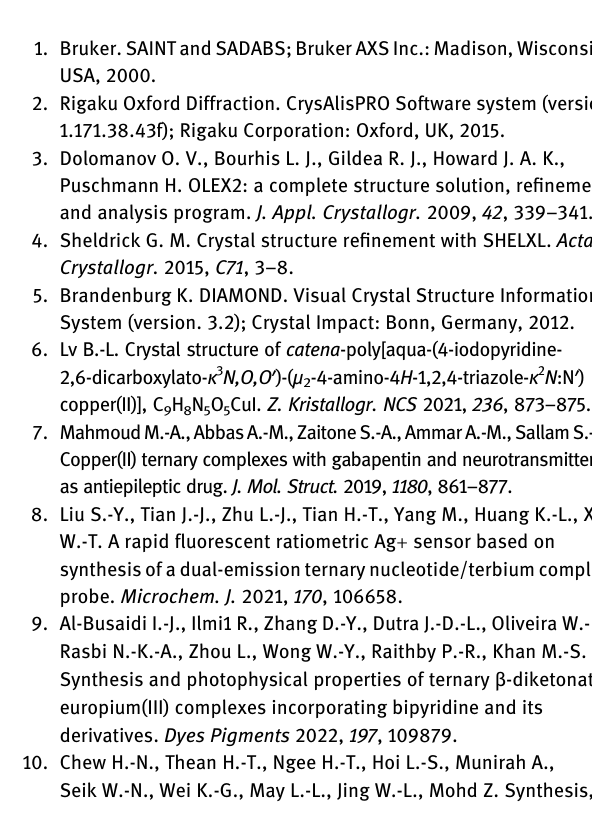
Table  : Fractional atomic coordinates and isotropic or equivalent isotropic displacement parameters (Å 